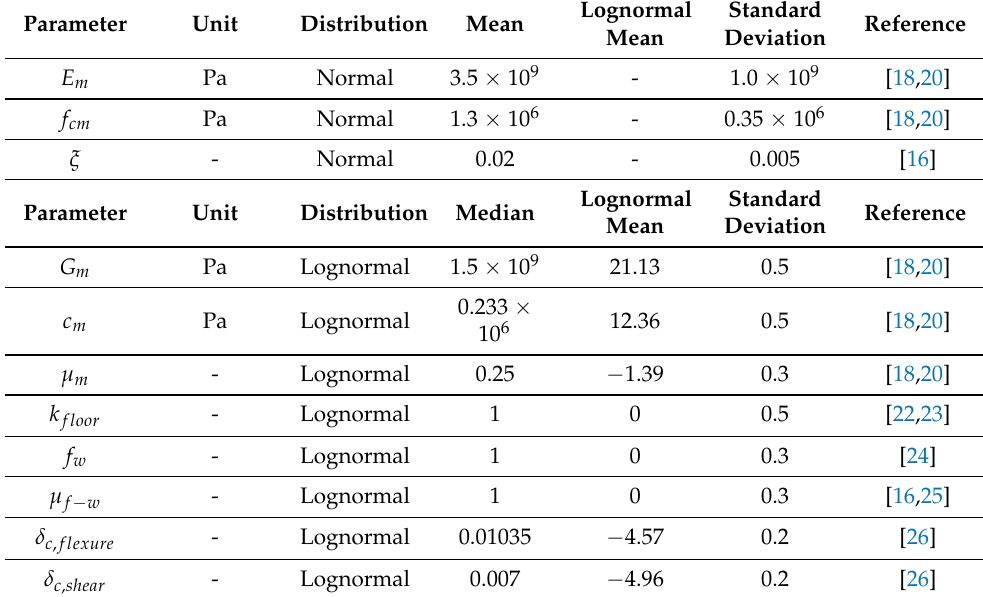
Table 1. Assumed distributions of material and modelling parameters.